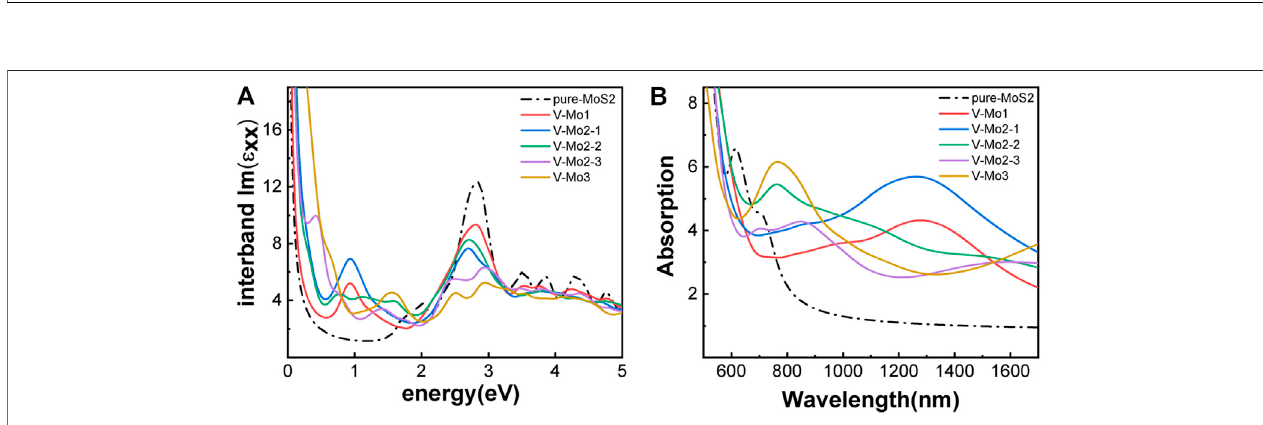
FIGURE 9 | Optical properties of monolayer 2H-MoS 2 with different Mo-vacancy defects: (A) the imaginary part of the dynamic dielectric function; (B) absorption spectra. The black dotted line is for pure monolayer 2H-MoS 2 . The labels in the legend refer to different vacancy structures, as shown in Figure 7 .